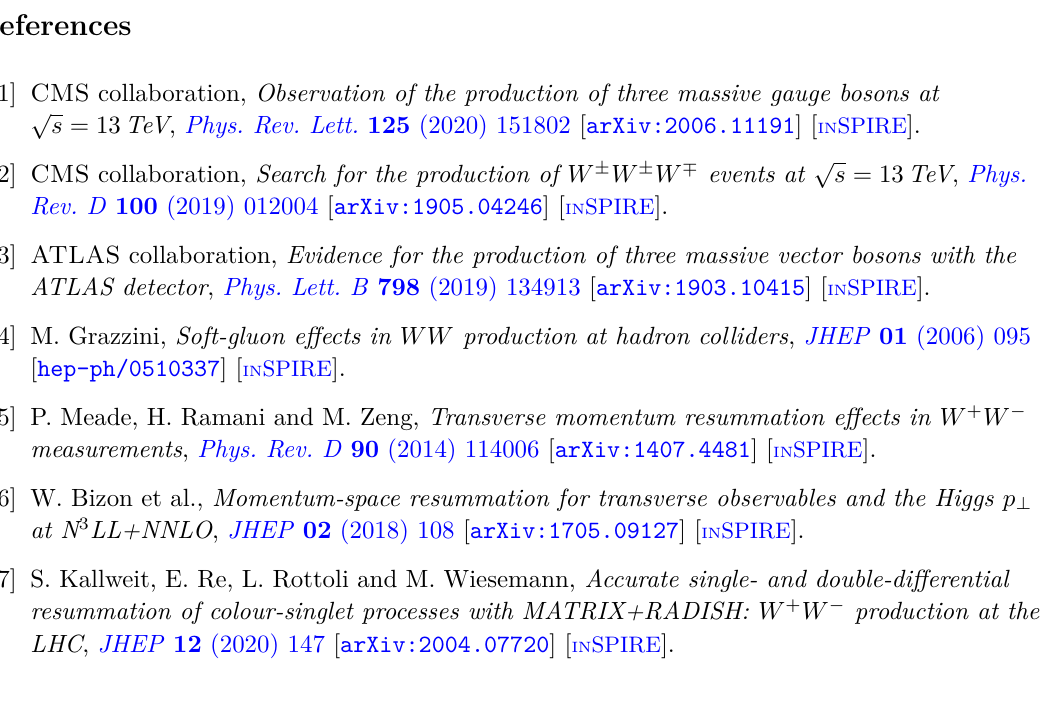
Figure 11 . The q ZH distribution at N 3 LL+NNLO compared to fixed order T